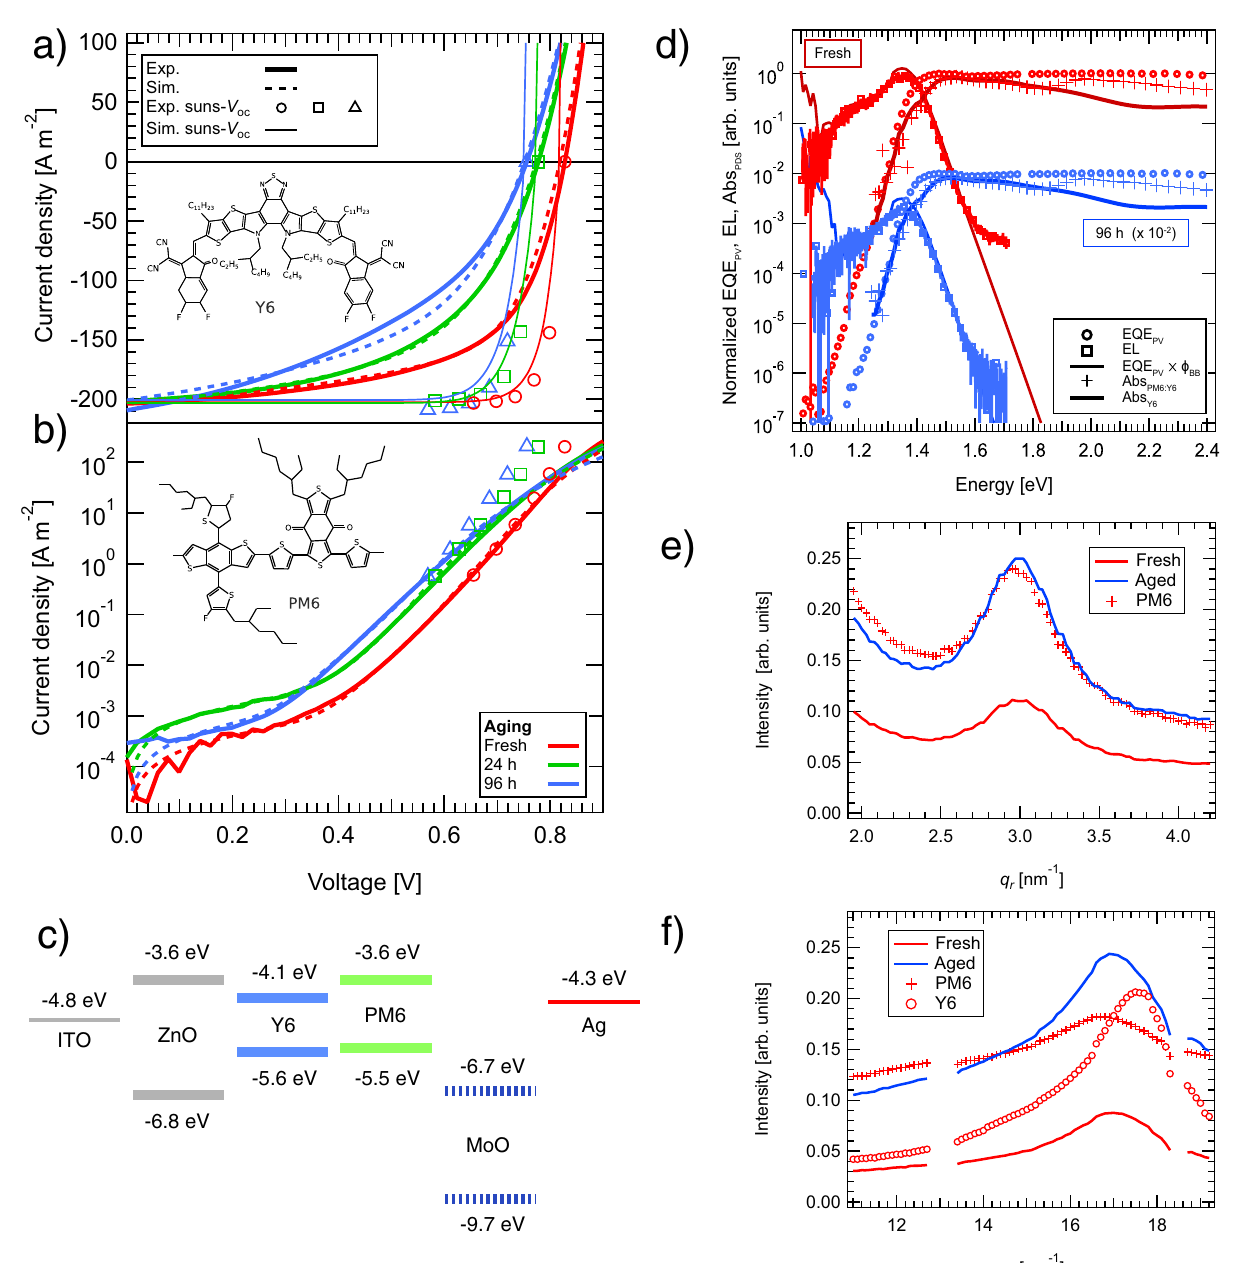
Fig. 2 Aging in fl uence on optical and electrical properties. a Illuminated and b dark current – voltage curves of fresh and aged 200 nm devices. For reference, the molecular structures of PM6 and Y6 are shown. c The schematic band diagram of the device. The energy level markers of MoO 3 are dotted because different values can be found in the literature. d Normalized absorption (Abs) was obtained using photothermal de fl ection spectroscopy, photovoltaic external quantum ef fi ciency (EQE PV ), and electroluminescence emission (EL) for fresh and 96 h aged samples at room temperature. Data from the aged sample was shifted down by two orders of magnitude for clarity. By comparing the external quantum ef fi ciency EQE PV multiplied by the 300 K black body spectra (EQE PV ⋅ ϕ BB ) to EL, it can be seen that they fi t very closely, suggesting through the reciprocity relation that the active layer absorption is dominated by Y6 around the 1.4 eV optical bandgap. e Extracted horizontal and f vertical information from 2D GIWAXS data of PM6:Y6/ ZnO/ITO samples. The gaps seen in the vertical information correspond to missing q -values due to detector gaps 43,44